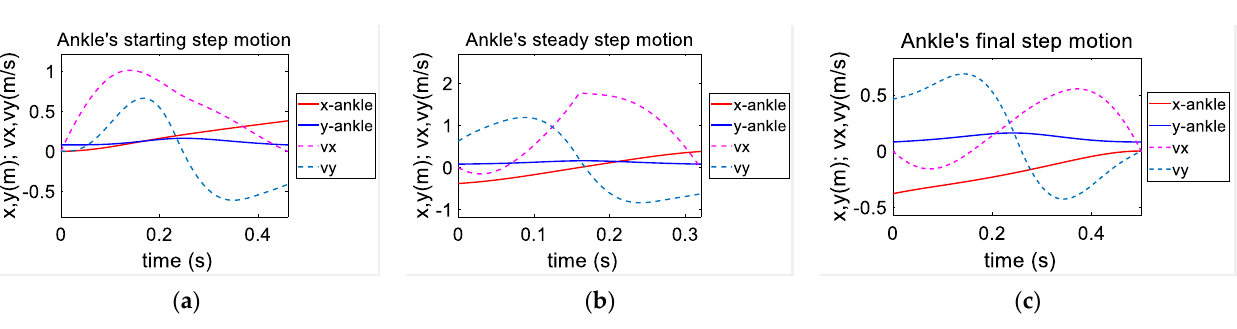
Figure 5. The motion of the hip joint in the starting ( a ), steady ( b ), and final ( c ) steps.